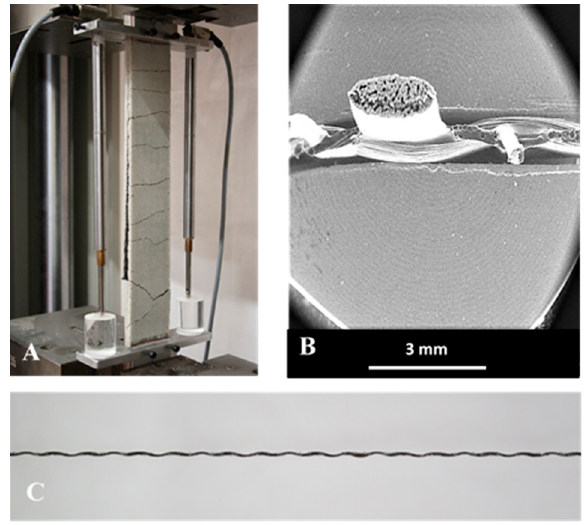
Figure 14. ( A ) Tensile test: crack pattern (end of stage II); ( B ) yarn transversal section; ( C ) waviness of the warp yarn.